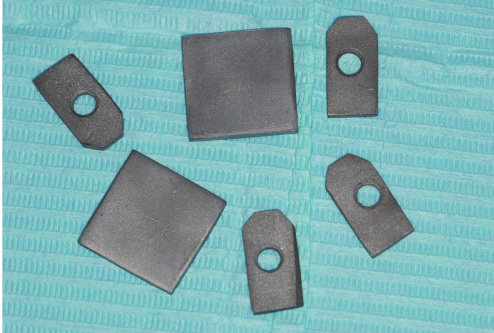
Figure 1: The metal plates used in the tests. Figure 2: Plates of group A welded by in-lab Nd :YAG laser welding.